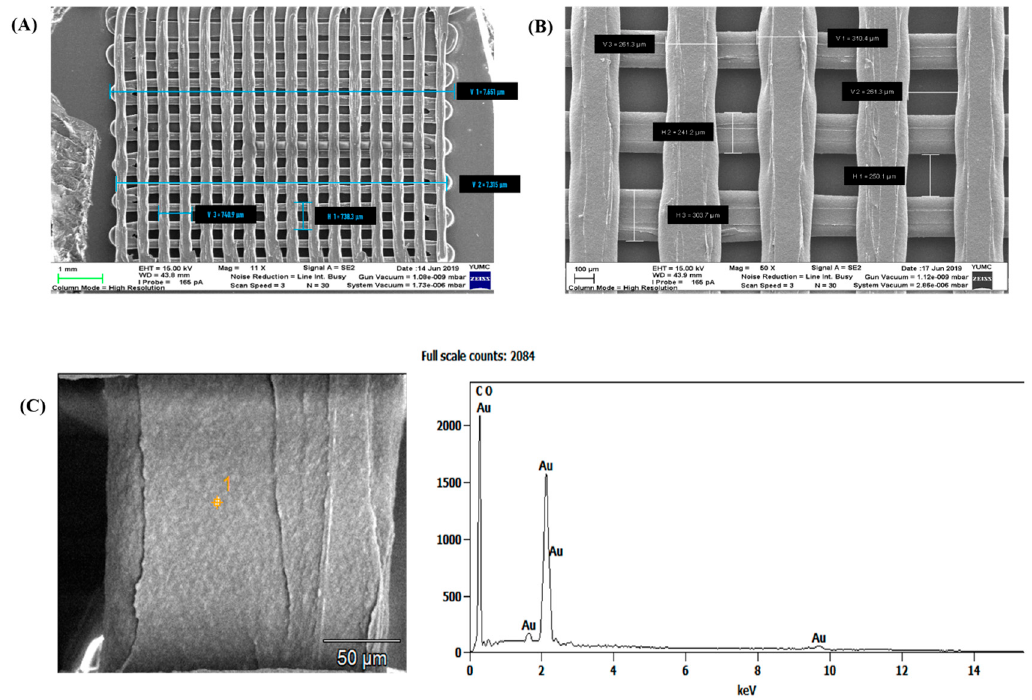
Figure 5. Optical characterization of the gold nanoparticles (Au-NPs)-coated industrial acrylonitrile butadiene styrene scaffold (GIA3D), printed with an infill density of 40%. ( A ) SEM images of the three-dimensional printed industrial acrylonitrile butadiene styrene sca ff olds (IA3D) with 40% infill density showing the overall size. Scale bar 1 mm. ( B ) SEM images of the IA3D with 40% infill density showing pore size and fiber width. Scale bar: 100 µ m. ( C ) Authentication of GIA3D with SEM, scale bar 50 µ m. SEM, scanning electron microscopy; EDS, energy-dispersive X-ray